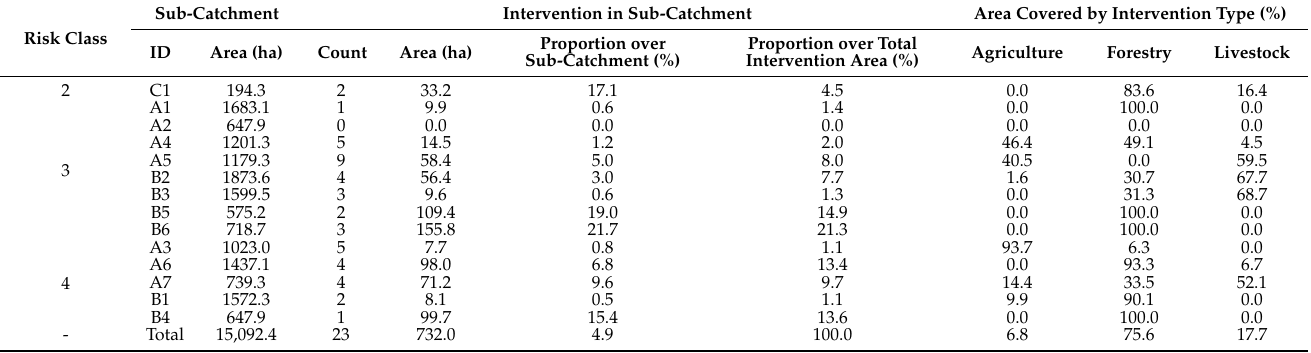
Table 10. Intervention type, area, and relative risk class in each of the sub-catchments of the study